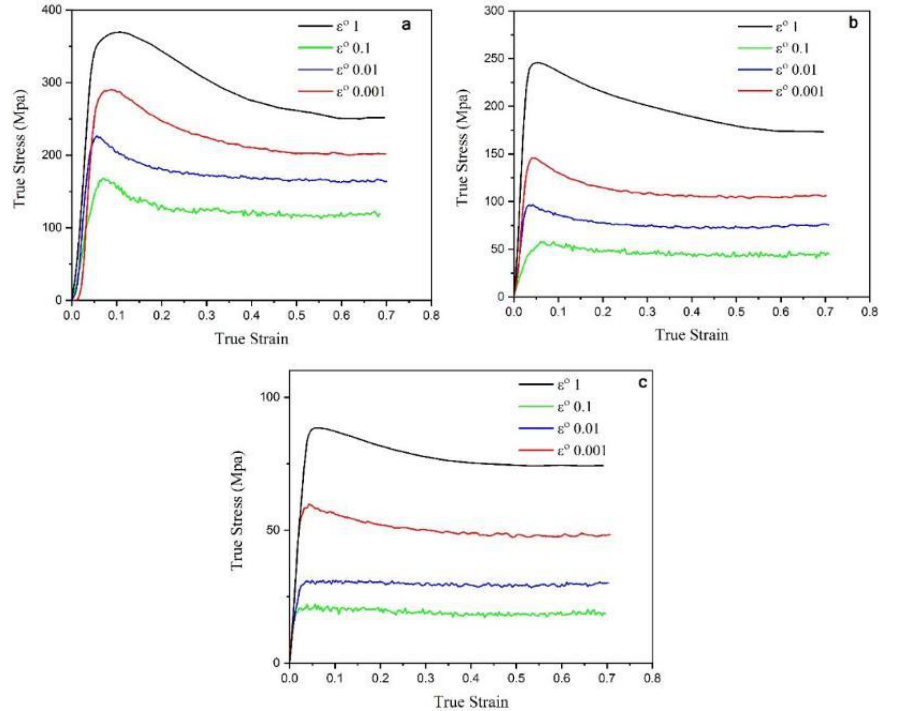
Fig. 3. Stress vs strain curve of the studied alloy at various deformation condition (i.e., strain rate and temperature): (a) 700℃ (b) 800℃ and (c)